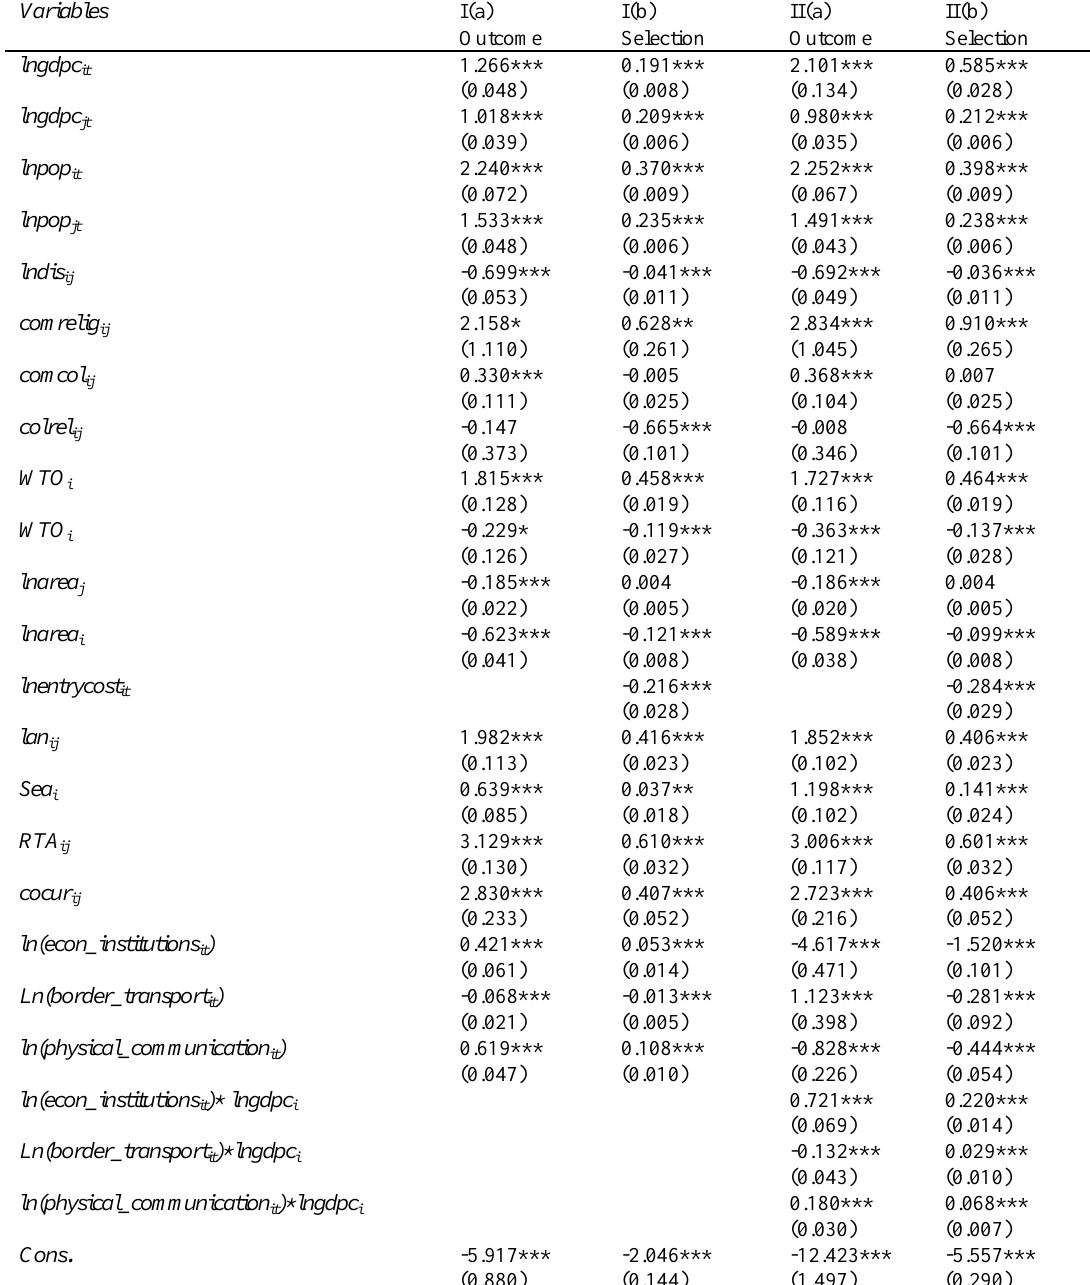
Table 10 : The marginal effects of quality of economic institutions, transport efficiency and infrastructure on trade flow (two-step